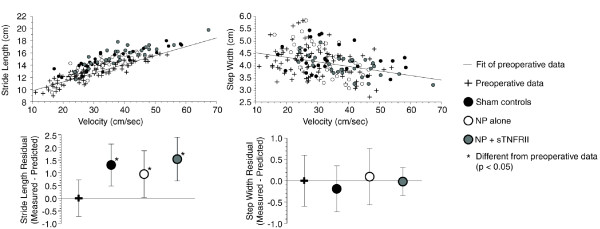
Stride length and step widths in rats with lumbar radiculopathy (five days post-operation). A significant correlation between stride length and velocity is observed in walking rats (upper left); raw data with a linear fit of the pre-operative data are shown. As velocity increases, stride length increases. Even after accounting for this correlation, stride lengths were found to increase in sham controls, animals with NP alone, and animals with NP and sTNFRII (*, lower left, P <0.016). A weaker, but important, correlation is also seen between step width and velocity (upper right); again, raw data with a linear fit of the pre-operative are shown. Here, as velocity increases, step widths narrow; however, after accounting for this correlation, no differences were observed in step width between groups (lower right). Data in lower graphs are presented as mean ± standard error.